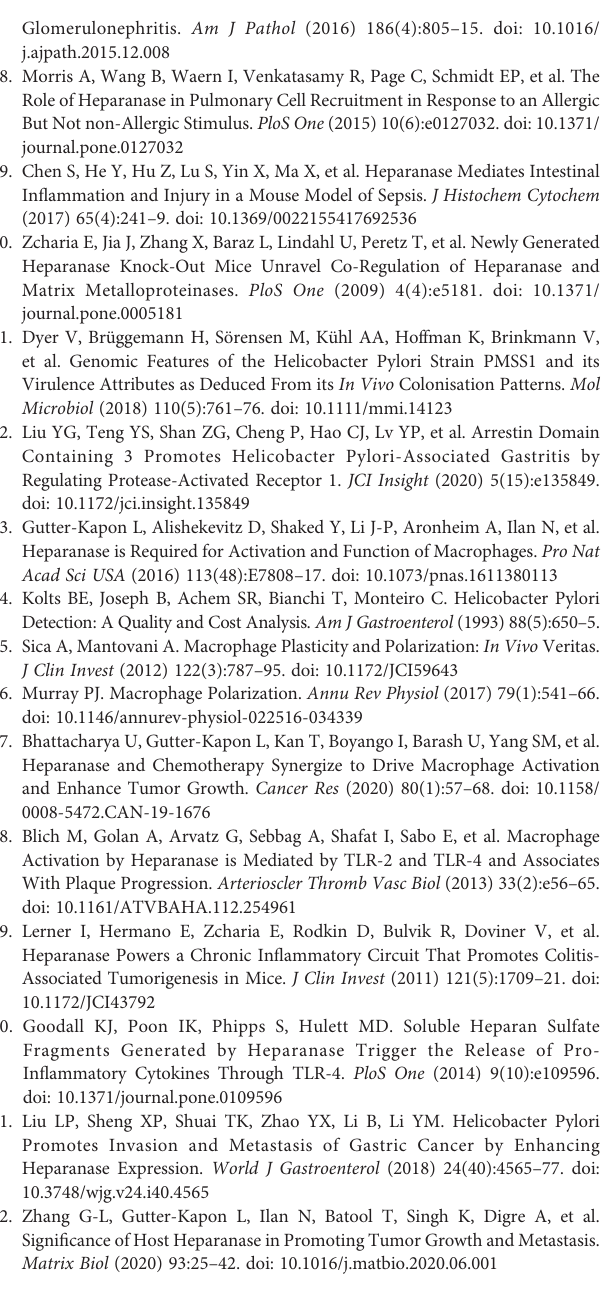
Supplementary Figure 1 | Semi-quantitative scoring of immunohistochemical and immuno fl uorescence results. (A) Semi-quantitative scoring of the immuno fl uorescence presented in Figure 1A (n=4 for each group). (B) Semi- quantitative scoring of immuno fl uorescence presented in Figure. 1C (n=4 for each group). (C) Semi-quantitative scoring of the immunohistochemical study presented in Figure 1D (n=4 for each group). Supplementary Figure 2 | ELISA quanti fi cation of all the pro ‐ in fl ammatory and pro ‐ tumorigenic cytokines presented in Figure 2C . WT Hp+: n=6, KO Hp+: n=5. *p<0.05. * p<0.05; **p<0.01; ***p<=0.001; ns: no signi fi cant difference. Supplementary Figure 3 | Culture and Gram staining of two H. pylori -positive samples. Gastric mucosa tissues were grinned into tissue homogenates and